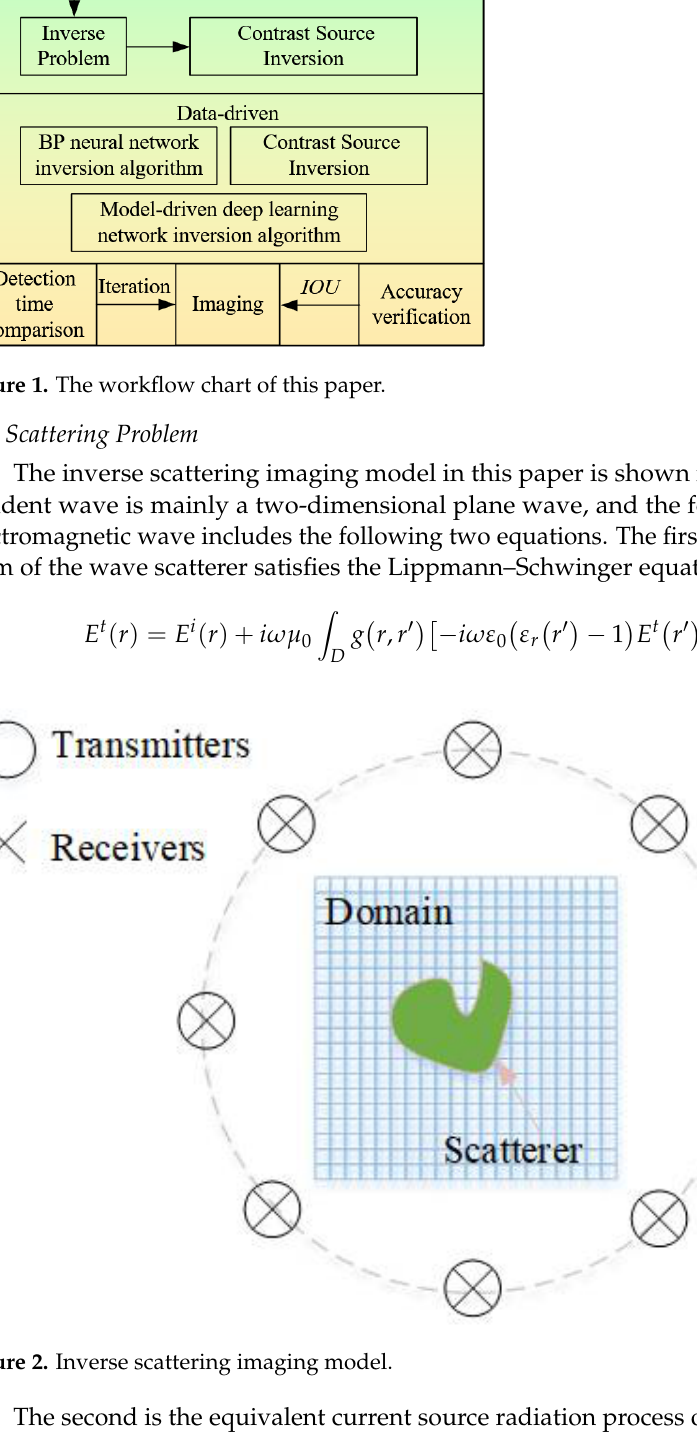
Figure 2. Inverse scattering imaging